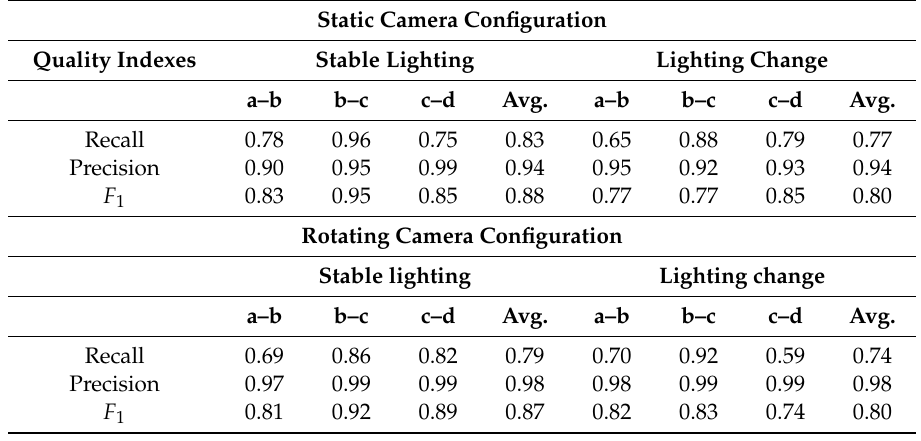
Table 1. The quantitative indices of the foreground